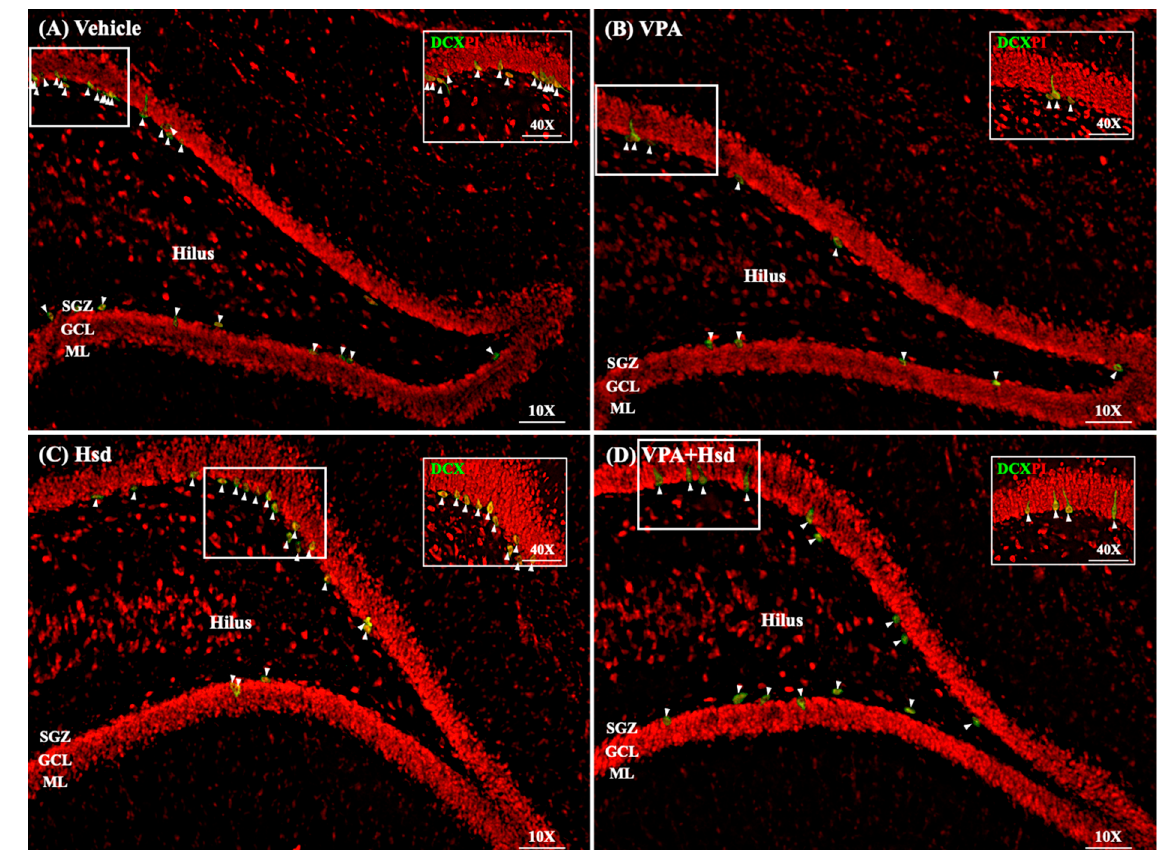
Figure 9. The immunostaining of immature neurons in the SGZ of the hippocampal DG ( A – D ). Doublecortin (DCX)-positive cells are stained green in the SGZ, and all nuclei are counterstained with the red nuclear dye, propidium iodide. Arrowheads indicate DCX-positive cells in the DG (scale bars: 100 μ m). Inserted figures show high magnification of DCX immunostaining (scale bar: 50 μ m).